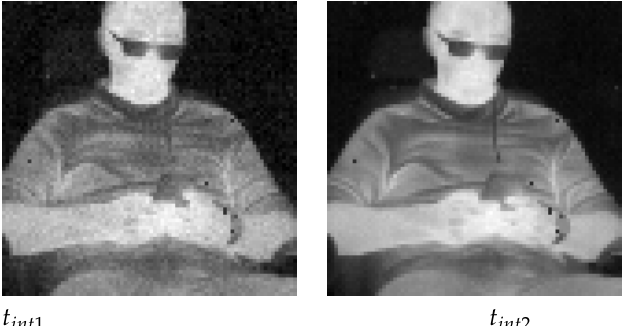
Figure 20. Two thermograms of the same scene acquired with different integration times ( t int 1 = 82.05 µ s; t int 2 = 328.21 µ